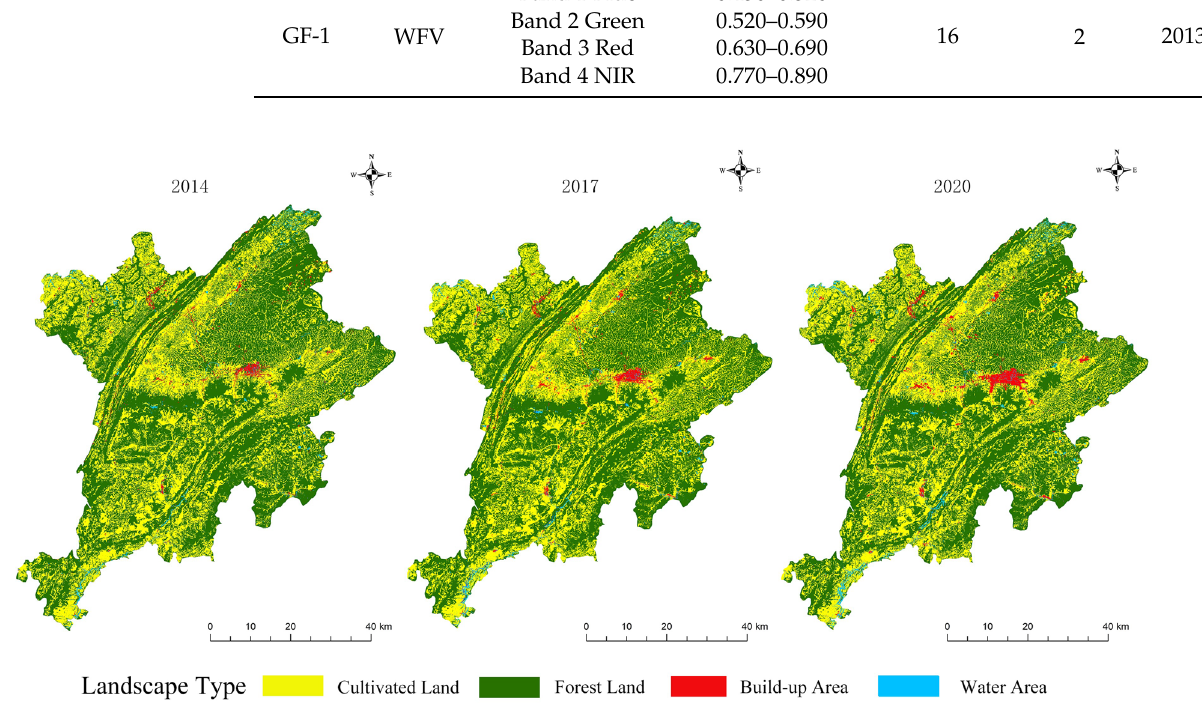
Figure 3. Landscape pattern of the audit area in 2014, 2017 and 2020.